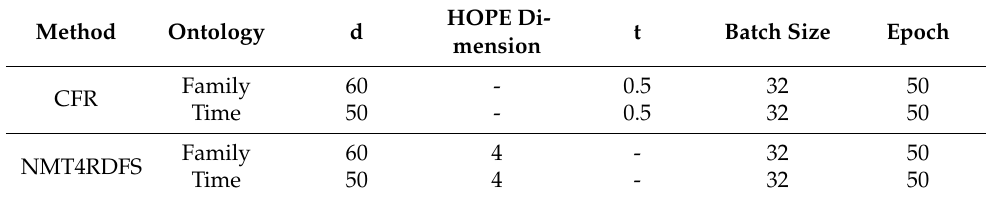
Table 4. Parameter Settings of the CFR and NMT4RDFS in the Experiments.